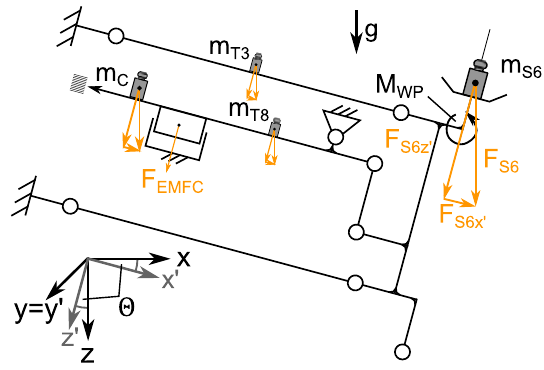
Figure 11. Tilt influence on mass determination